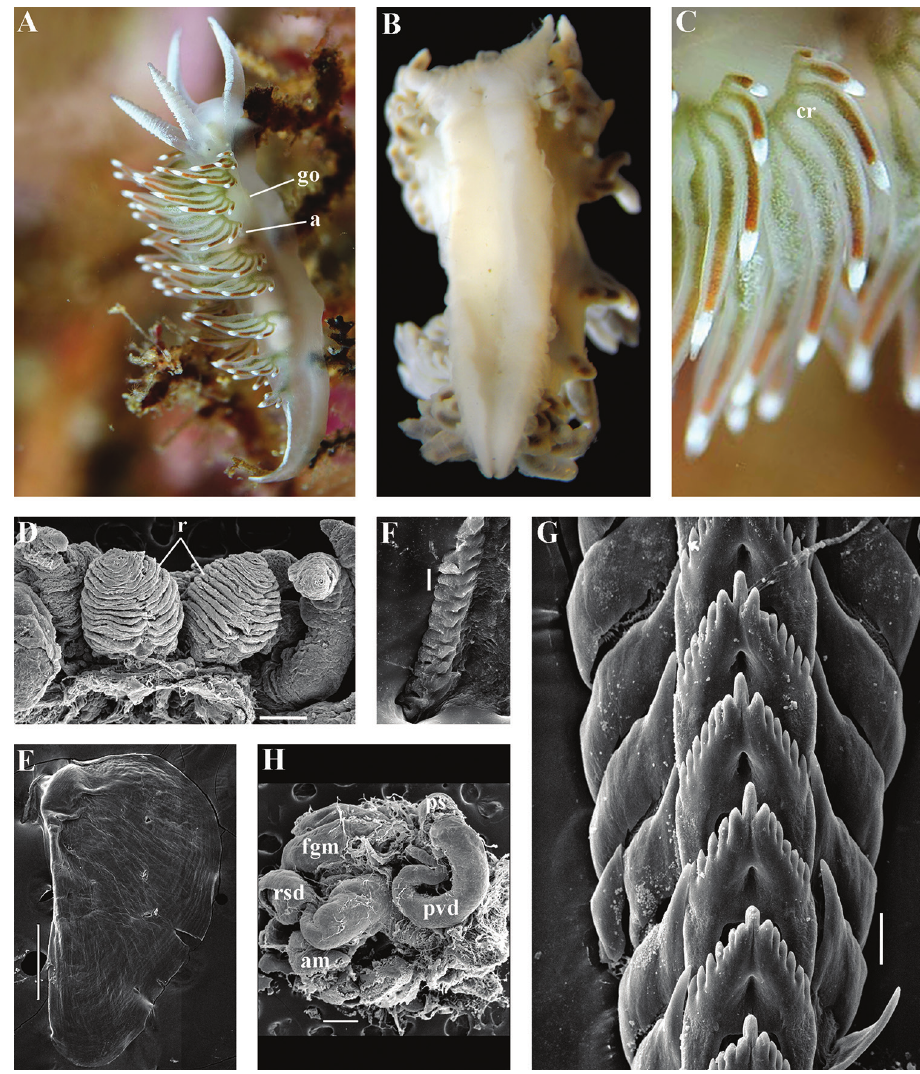
Figure 48. Apata pricei komandorica subsp. n. North West Pacific, Commander Islands. ZMMU Op- 533, living specimen 8 mm in length: A dorso-lateral view B ventral view (fixed) C details of cerata D rhinophores, SEM E jaw, SEM F details of masticatory process of jaw, SEM G radular teeth, posterior part H reproductive system, SEM. Abbreviations: a anus am ampulla cr ceratal rows fgm female gland mass go genital opening ps penial sheath pvd prostatic vas deferens r rhinophores rsd distal receptacu- lum seminis. Scale bars: D, E, H = 300 μm; F = 10 μm; G = 30 μm. Photos of living specimens by N.P. Sanamyan other photos and SEM images by A.V.